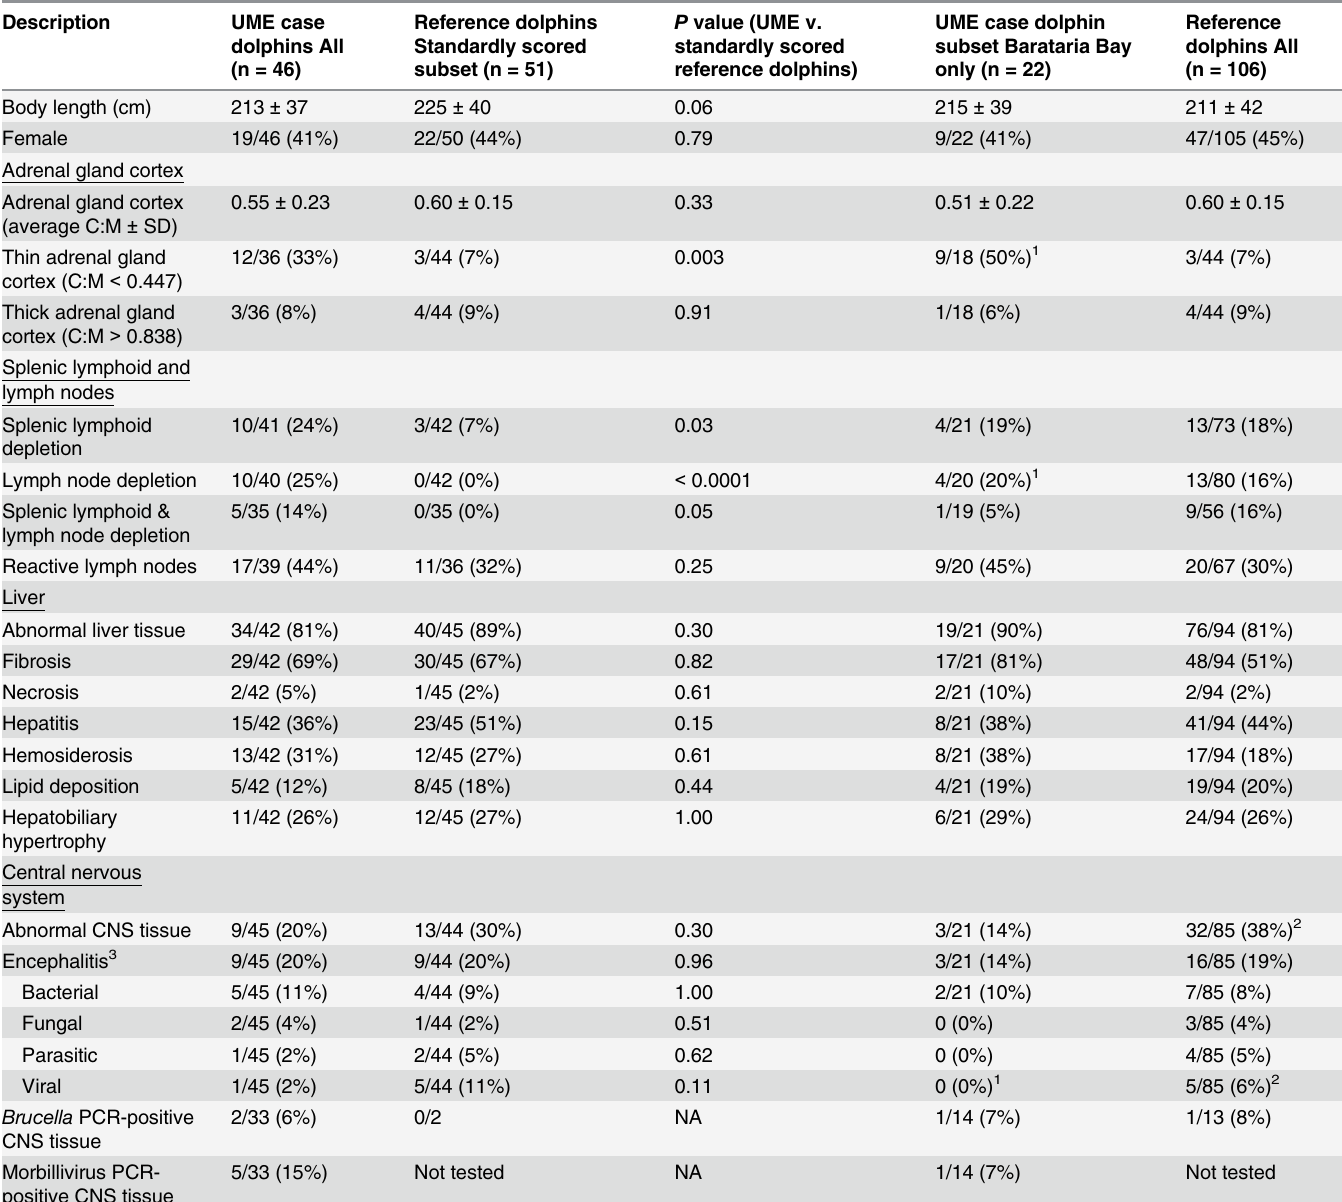
Table 2. Prevalence comparisons of lesions detected using histologic examination for fresh dead, stranded common bottlenose dolphins ( Tur- siops truncatus ) among 1) UME cases from Louisiana, Mississippi, and Alabama, 2) Barataria Bay, Louisiana UME subset, 3) all reference dol- phins, and 4) slide-reviewed and standardly scored reference dolphin